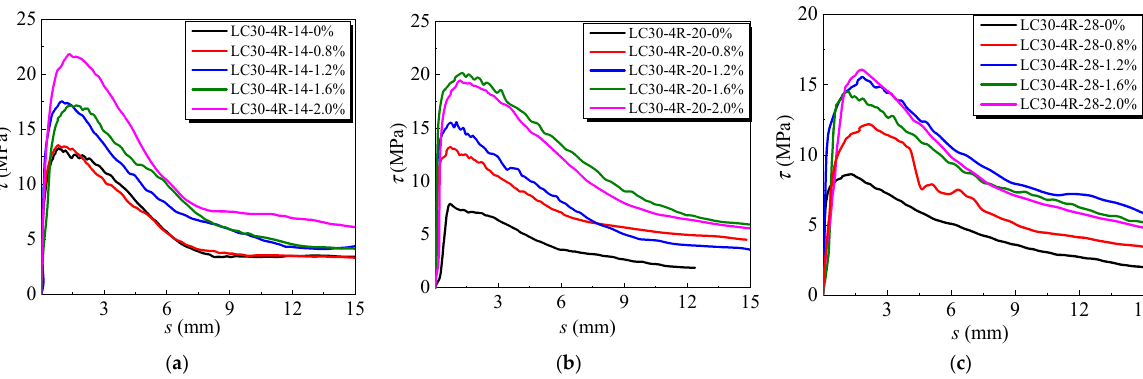
Figure 5. Bond stress-slip curves of specimens with different v f at: ( a ) d = 14 mm; ( b ) d = 20 mm; ( c ) d = 28 mm.